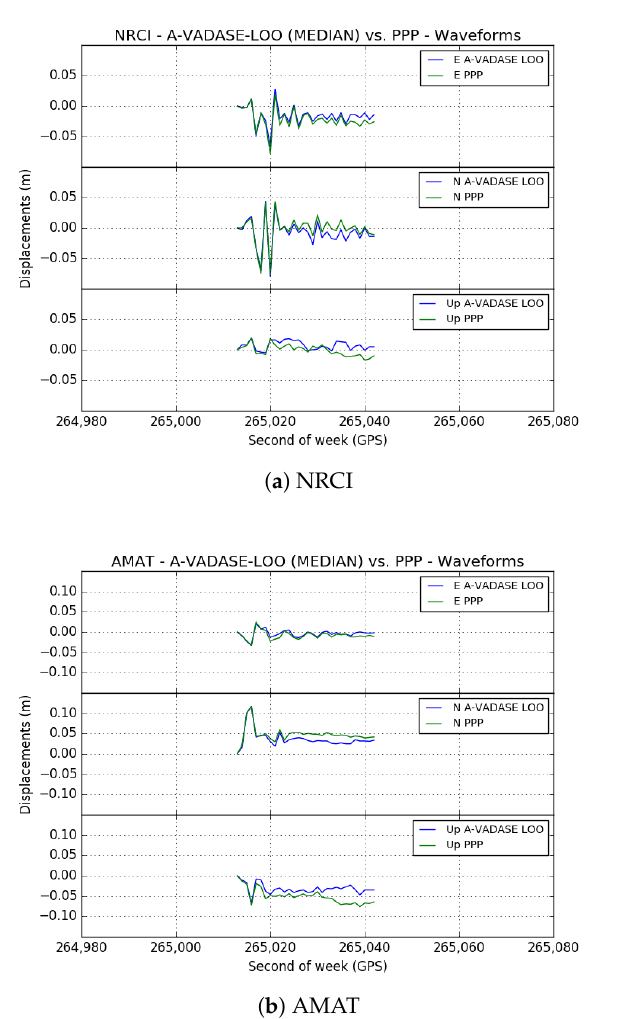
Figure 7. A-VADASE-LOO vs. PPP in the 30-s interval across the 24 August 2016 main shock (GPS